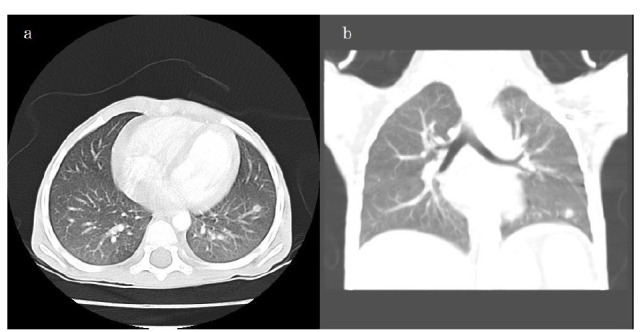
 Spiral computed tomography scan of the chest and mediastinum without contrast (with coronal reconstruction)
(Multiple axial and coronal images through the chest and mediastinum demonstrate a small nodule measuring
about 5×5 mm in the left lower lobe [axial (a) and coronal (b) views]).